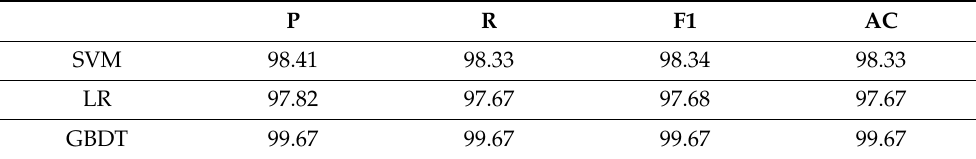
Table 2. Performance comparison using different algorithms on S 11 .